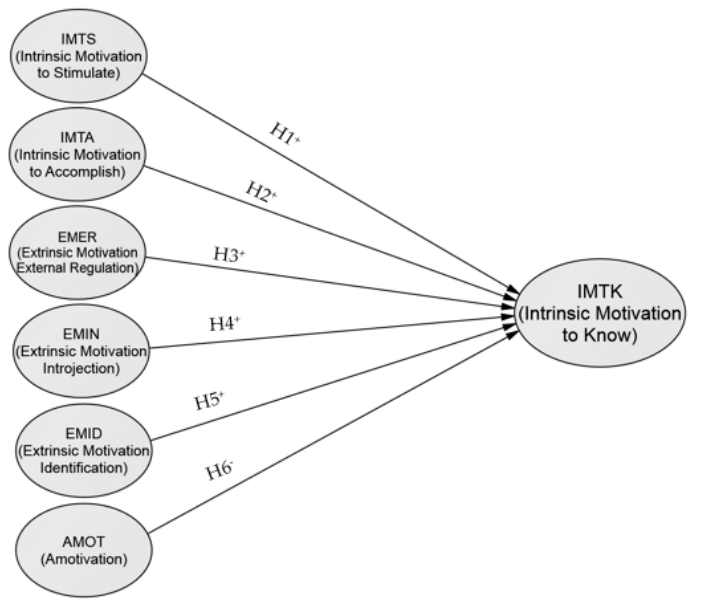
Figure 1. Research Figure 1. Research Model.